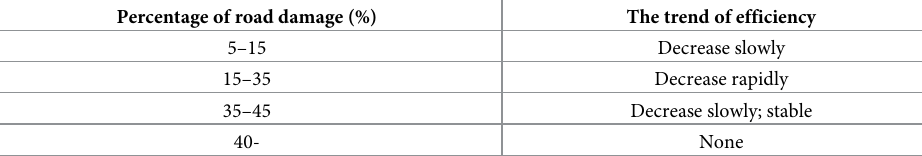
Table 16. S-curve change trend of accessibility of